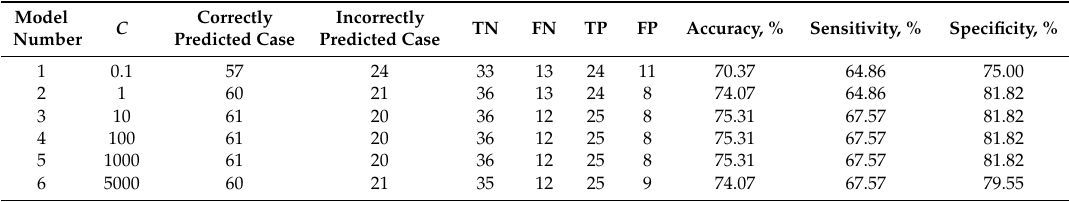
Table 16. Prediction results for the SVM model using the linear kernel